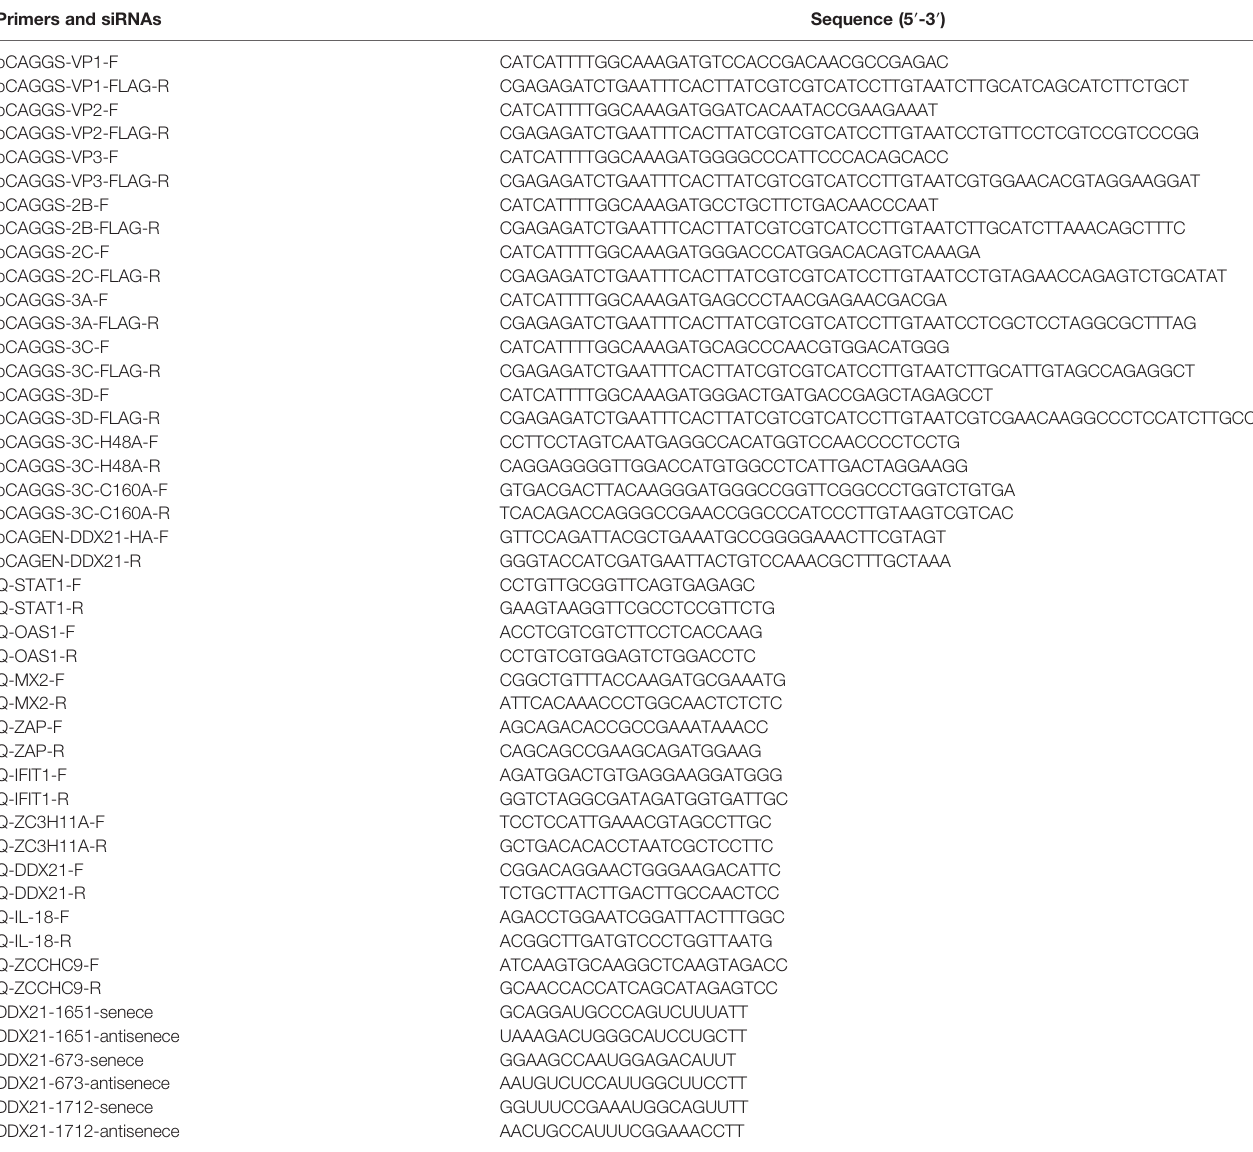
TABLE 1 | The sequence of primers and siRNAs used in the